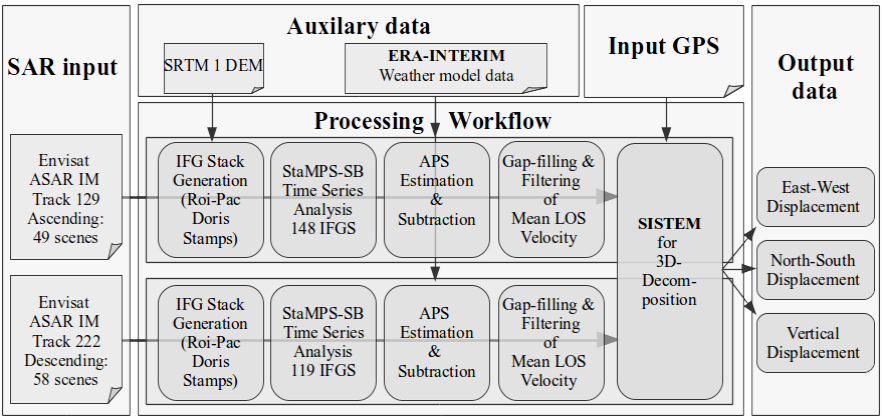
Figure 2. Data collection, processing and integration